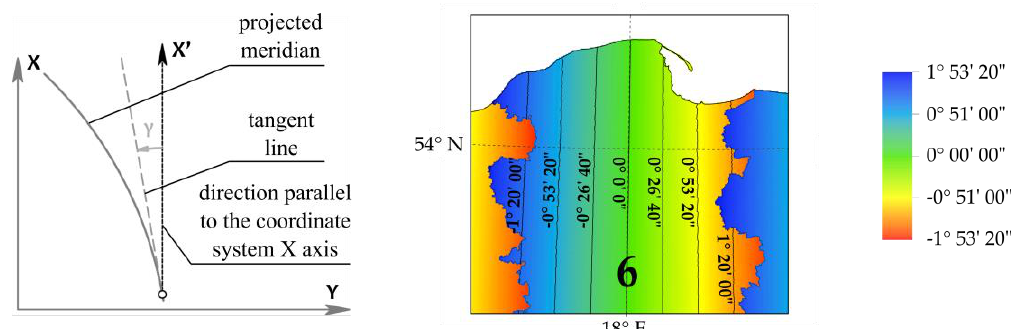
Figure 7. Convergence of the meridian projection in the PL-2000 coordinate system and its values for the area of Pomeranian Voivodship.